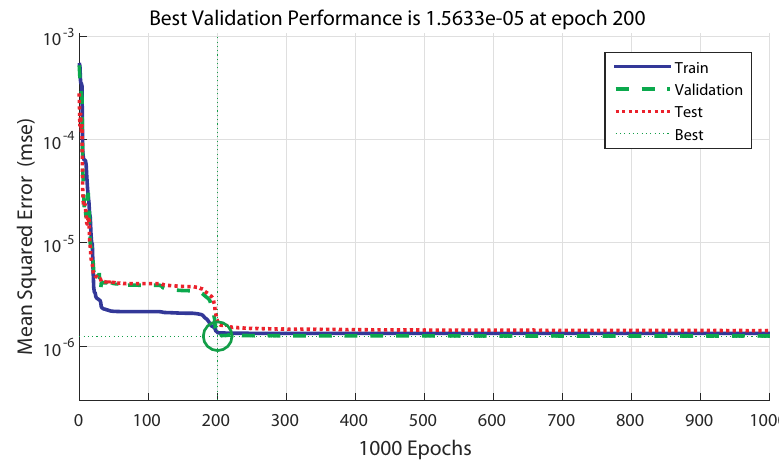
Figure 18. Training performance for a network of 2 × 8 × 4 × 1 (ANN2).